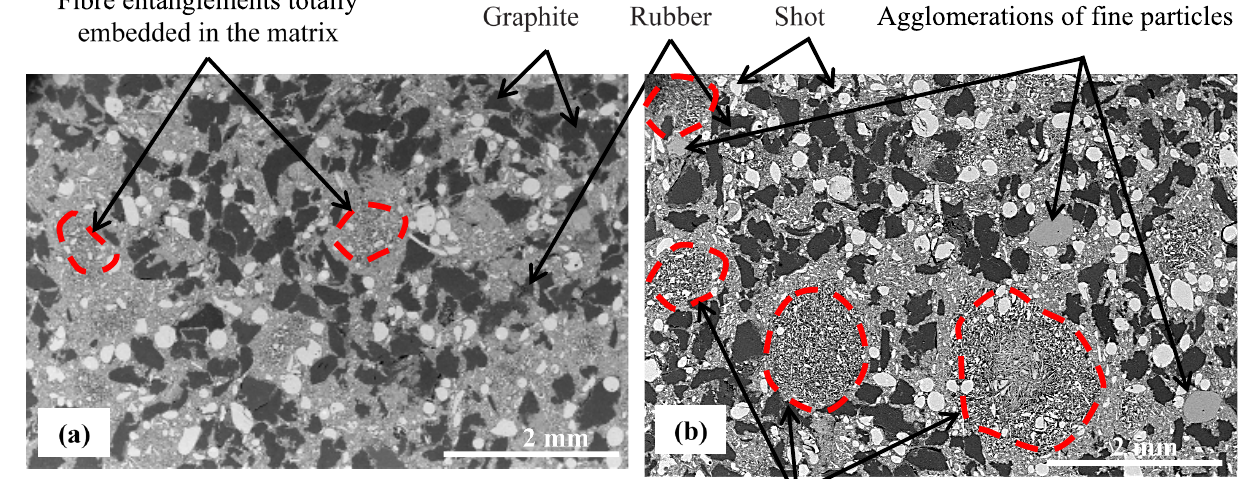
Figure 3. Microstructure of materials ( a ) M1 and ( b ) M2 (SEM-BSE).